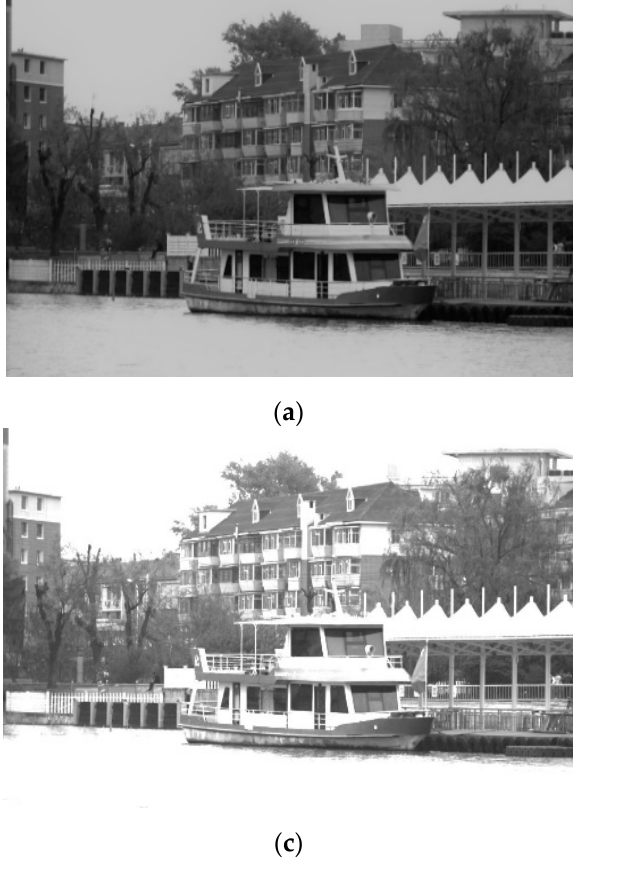
Figure 11. ( a ) The original polarization image S 0 . ( b ) the original infrared image. ( c ) the polarization fused image. ( d ) the degree of linear polarization image.